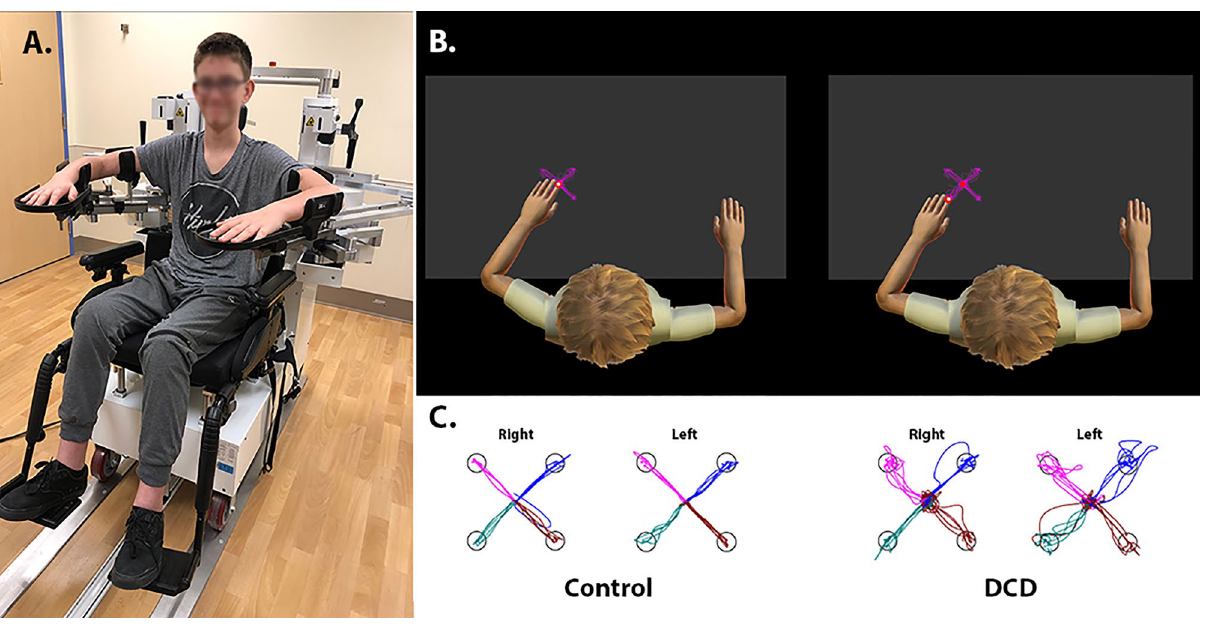
Figure 1. ( A ) Participant shown in the Kinarm exoskeleton robot, equipped with a wheelchair base and arm troughs supporting each arm in the horizontal plane; ( B ) schematic of the Kinarm workspace for the visually guided reaching task. The graphic demonstrates a reaching movement of a DCD participant. The participant’s fingertip begins within the centered red illuminated target. A peripheral target will appear, in which participants will then reach to that target as quickly and accurately as possible. ( C ) Right- and left-hand path trajectories, for the four peripheral spatial targets, are shown for a typically developing control and a DCD participant of similar ages; note that participants arms were visually occluded and hand position feedback was provided by the virtually displayed white dot placed over the tip of the index ardized scores based on normative data of 1172 children from the United Kingdom (mean population standard score 10 ± 3) and takes approximately 30 minutes to administer. The MABC-II is comprised of three subscales: (1) Manual Dexterity, where the number of errors are counted on a drawing task and participants are timed on a peg placing task as well as a threading lace or building task; (2) Aiming and Catching, where participants were scored out of ten on the number of successful ball catches as well as tosses at a target; (3) Balance, where participants are timed during performance of a one or two-legged balance task, as well as scored on the number of successful heel-to-toe-steps made, up to a maximum of fifteen, and the number of one-legged jumps made across five consecutive mats. Raw scores are converted into age standardized item scores for each subscale item. These standard scores are summed to get an overall component score for each subscale, which is converted into a standard score and a percentile. A Total Test score is calculated by summing each of the subscale component scores and correspondingly calculating a standard score and percentile. A Total Test score below the 16th per- centile indicates the presence of motor deficits 35 . DCD participants also completed the Wechsler Abbreviated Scale of Intelligence-Second Edition (WASI-II) 40 , administered by the same trained investigator (MNG). The WASI-II is a standardized assessment that provides a valid and reliable measure of intelligence 41 . All four WASI-II subtests were completed (i.e., Block Design, Vocabulary, Matrix Reasoning and Similarities). Full scale IQ scores of < 80 are indicative of cognitive deficits 40 . Robotic assessment. seated into a wheelchair base with each arm supported in the horizontal plane by the exoskeleton structure (Fig. 1a; written consent for the publication of an identifying image in an open-access journal was obtained from the participants legal guardian). Adjustments were made for participant height and length of arm reach. Once fitted, participants were wheeled into an augmented reality workstation and a standard calibration procedure was undertaken before beginning the motor tasks. Visually guided reaching task. Participants were instructed to “reach as quickly and accurately as possible” from a fixed central position to one of four peripherally located spatial targets. Targets were 6 cm apart, appearing as red dots on the display screen. Participants arms were visually occluded; however, hand position feedback was provided by a virtually displayed white dot placed over the tip of the index finger (Fig. 1b,c). Participants com- pleted a total of five blocks, each consisting of four randomly generated peripheral target locations. Participants completed the task with their dominant limb first, followed by their non-dominant limb. Task performance was measured at a sampling frequency of 1000 Hz using four selected parameters, which are outlined below. This visually guided reaching task has been described in detail previously 28,34 .